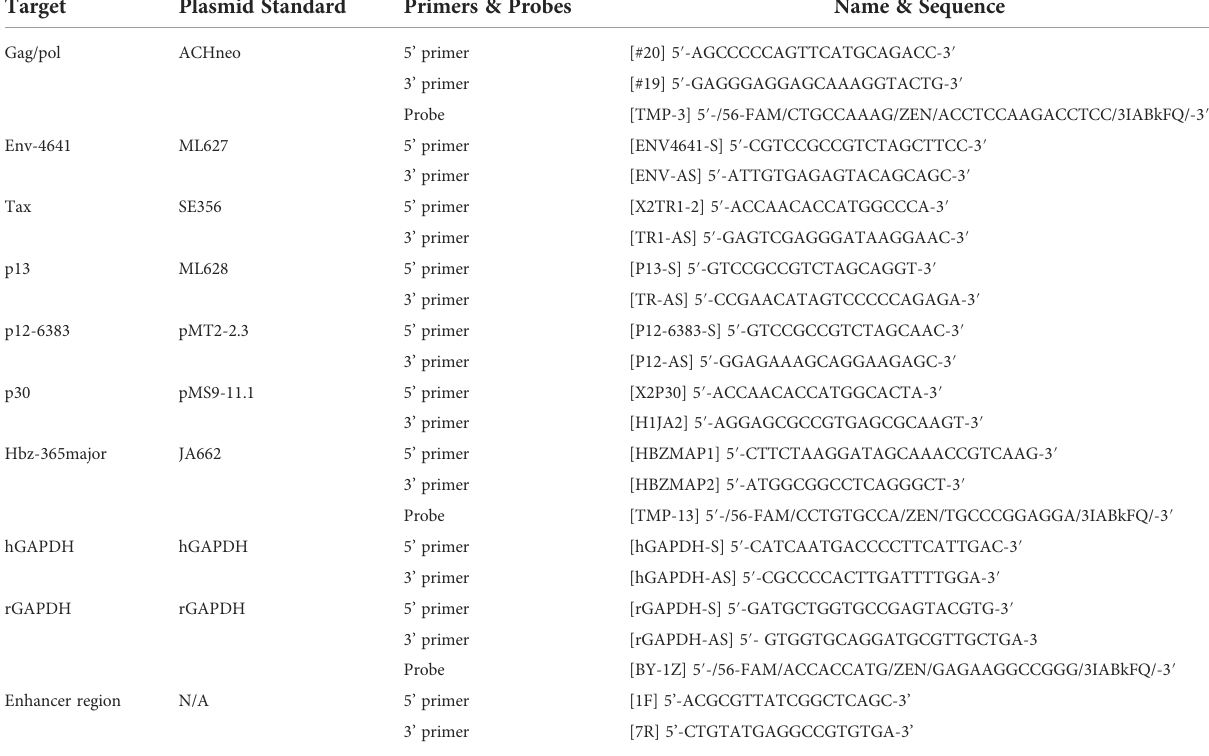
TABLE 1 Primer and probe